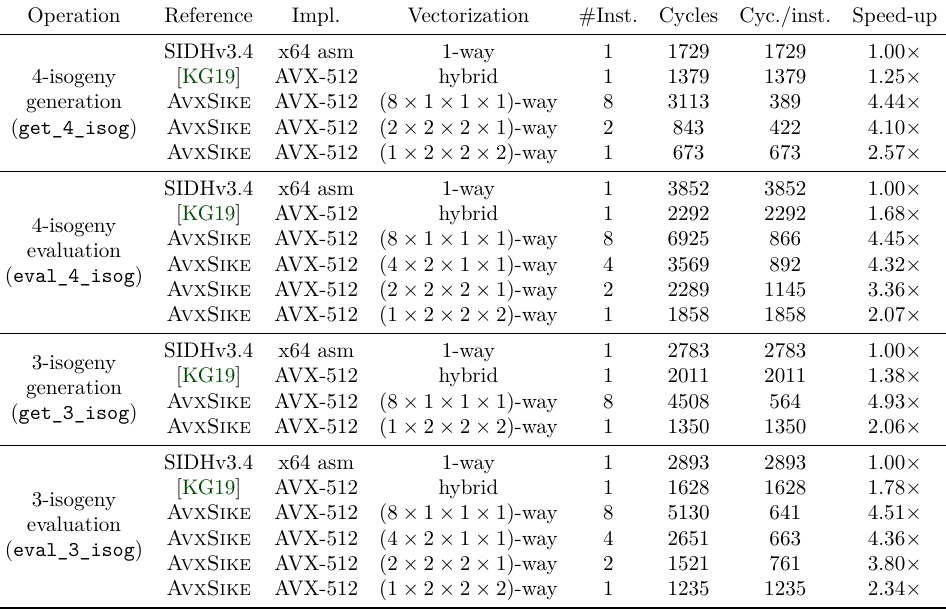
Table 4: Experimental results of isogeny-operation implementations for SIKEp503 . Operation Reference